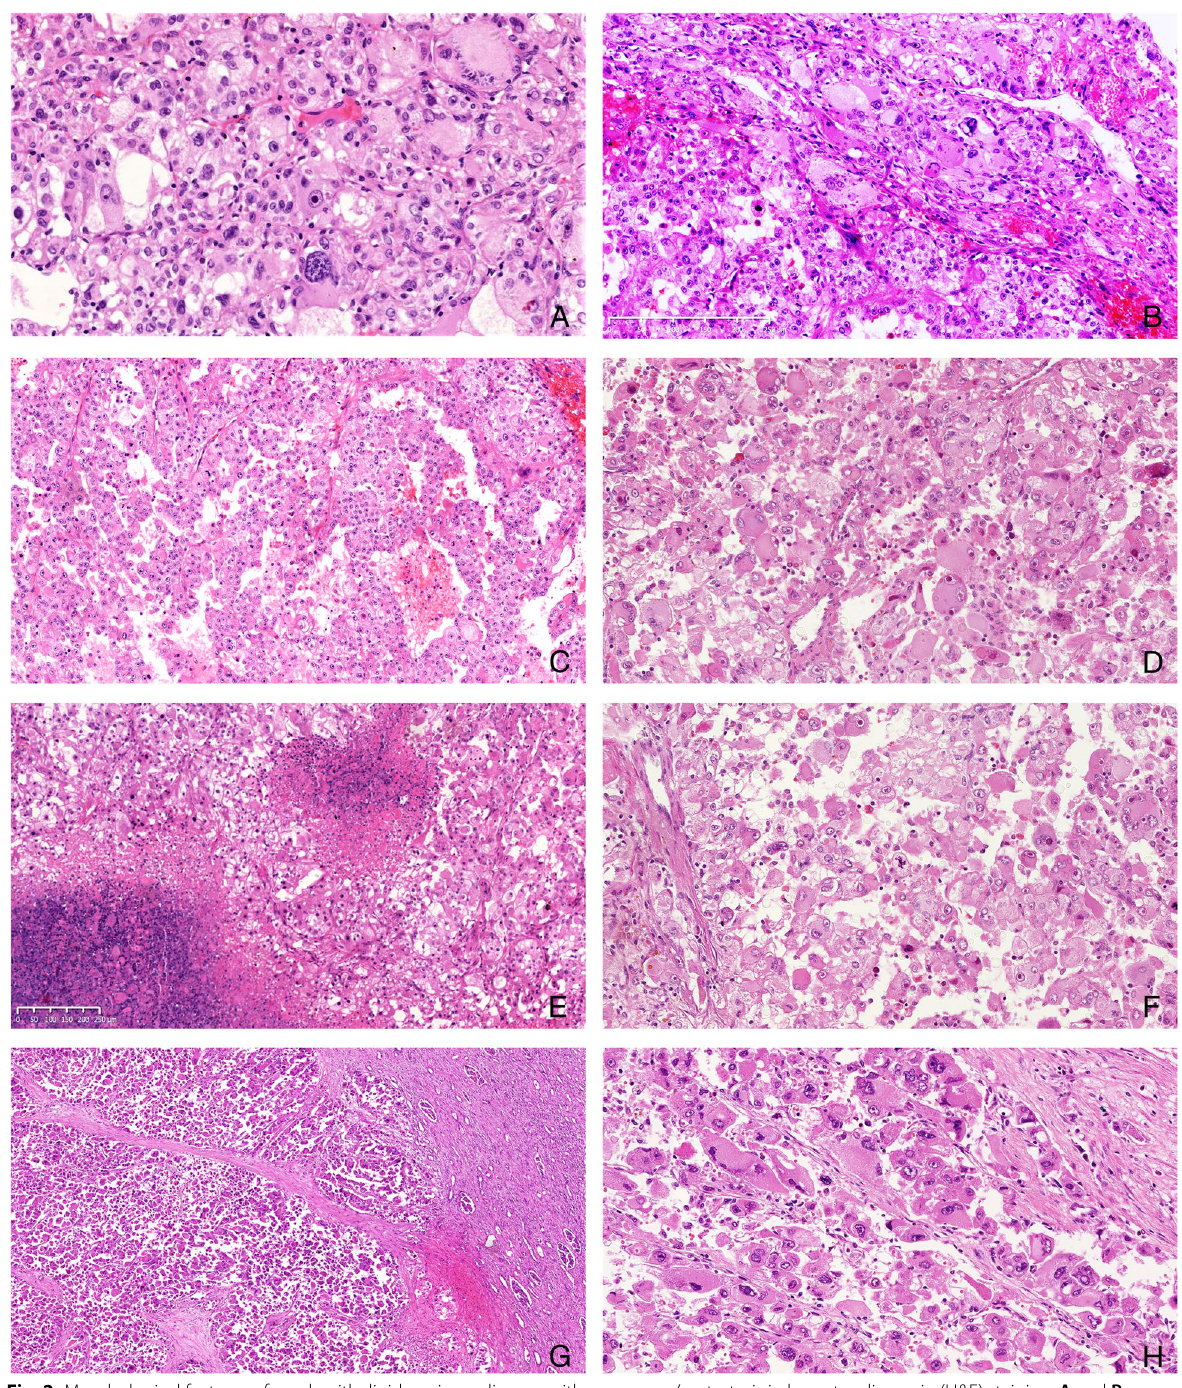
Fig. 2 Morphological features of renal epithelioid angiomyolipoma with recurrence/metastasis in hematoxylin-eosin (H&E) staining. A and B Carcinoma-like pattern, the tumor cells were arranged as cohesive nests separated by thin vascular-rich or fibrous septa; C Pseudoglandular configurations were present focally due to discohesive cells in the center; D Multinucleate giant tumor cells with similar nuclear features to background neoplastic cells were present in clusters; E Geographic tumor necrosis; F Pathological mitosis (in the center of image); G The neoplastic cells were diffusely discohesive; H The neoplastic cells were large with diffusely significant atypia: cytoplasm was abundant, dense and deeply eosinophilic, the nuclei were hyperchromatic and pleomorphic, and nucleoli were highly